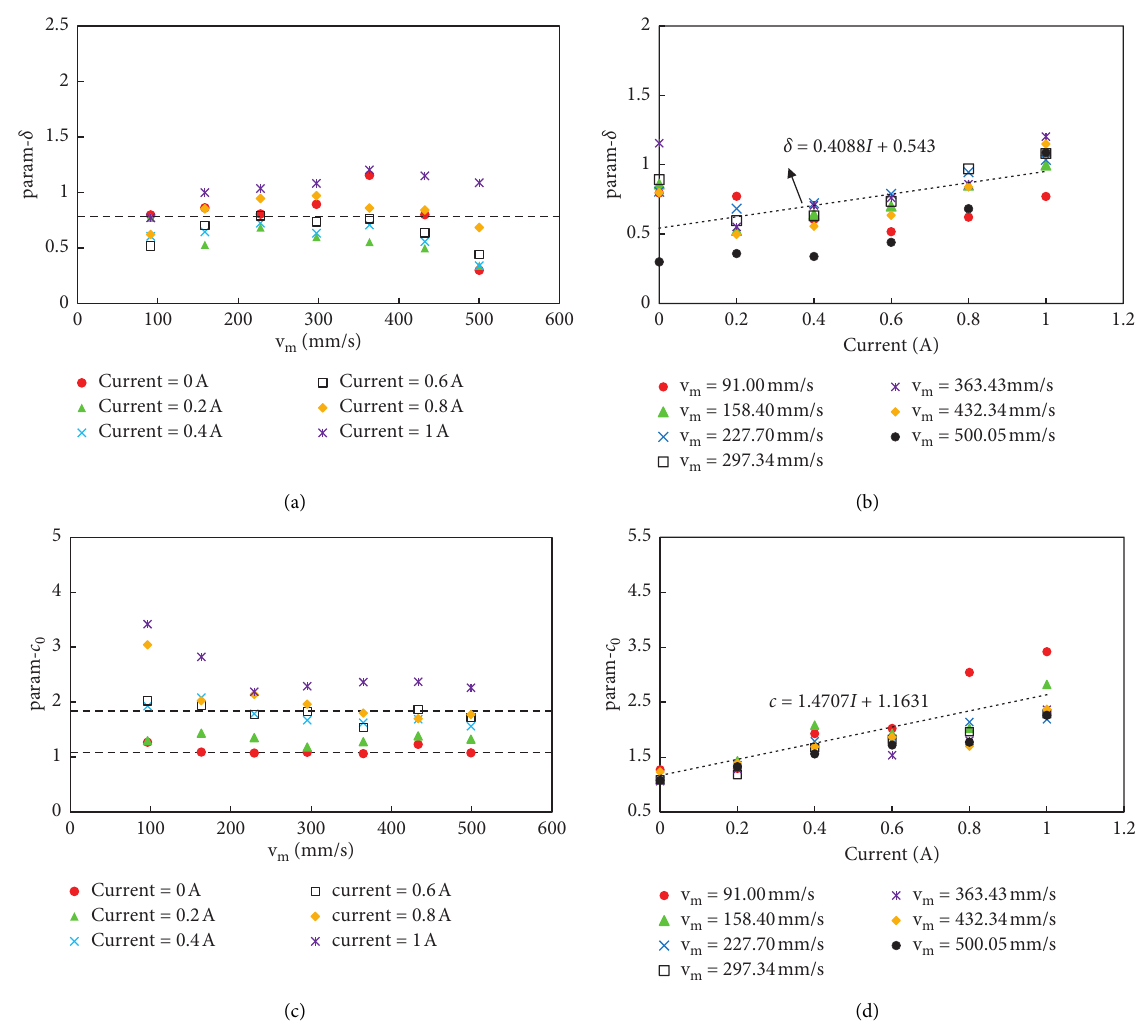
Figure 16: Identification results of parameters δ and c